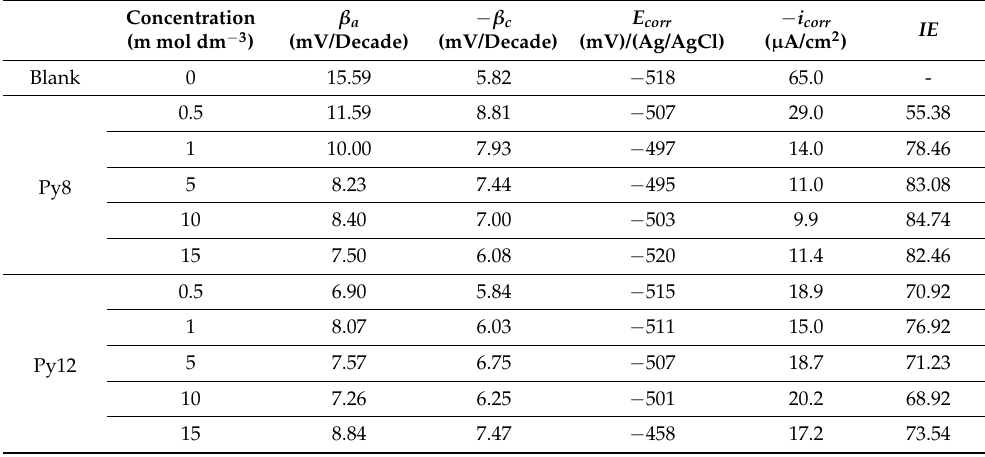
Table 2. Tafel Polarization parameters obtained for EN3B mild steel in the absence and presence of varying concentrations of Py8 and Py12 in 3.5% NaCl solution (pH =